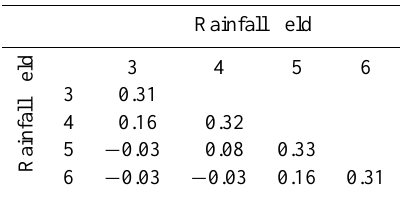
Table 2. Sensitivity analysis. Fitted sills (mm) using the spheri- cal model for direct and cross-variograms for rainfall fields 3–6 (see Fig. 7) derived for the dense synthetic observation network (Fig. 8c). Rainfall field